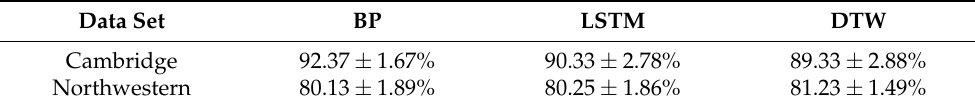
Table 4. Comparison between three different classification methods.